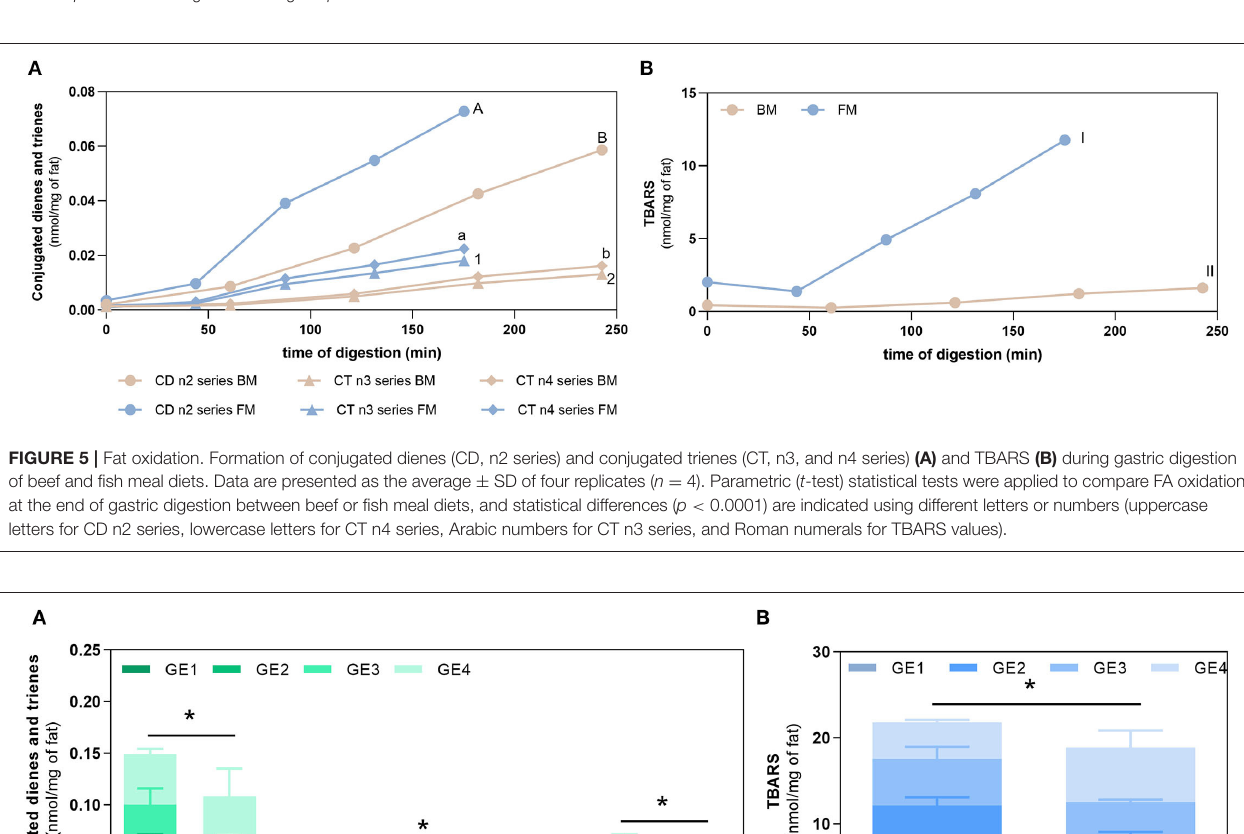
FA profile of FM before digestion ( ω 3 < SFA < MUFA < ω 6)